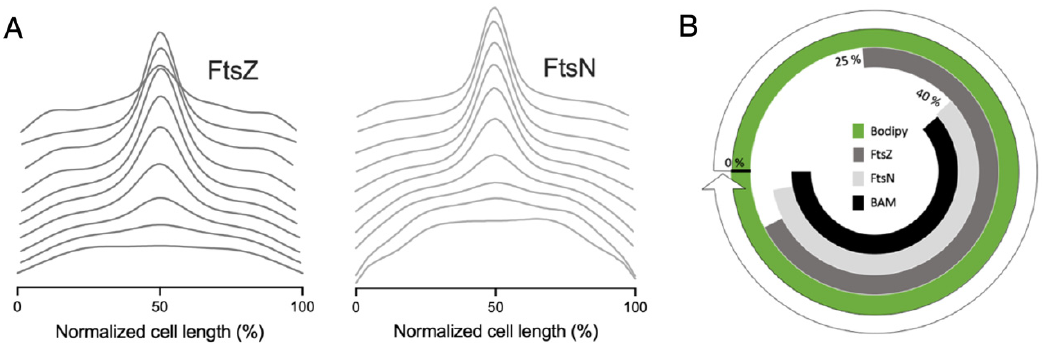
Figure 6. Midcell occurrence of FtsZ, FtsN. ( A ) LMC500 wild type cells grown to steady state in minimal medium at 28 ◦ C and immunolabelled against the division proteins FtsZ (dark grey) and FtsN (light grey). The FtsZ and FtsN fluorescence profiles were binned into 10 age classes (10% to 100%) and plotted as function of the normalized cell length. From the midcell enrichment, the timing of FtsZ and FtsN during the cell division cycle can be observed. FtsZ (n = 3300); FtsN (n = 5921). ( B ) The presence at midcell, represented as a circular timeline map, offers the timing of the divisome assembly: it starts at 25% with the accumulation at midcell of the ‘early’ protein FtsZ and ends with the localization at midcell of the ‘late’ division protein FtsN, around the 40% of the normalized cell division cycle age. BAM and FtsN are recruited simultaneously at midcell.